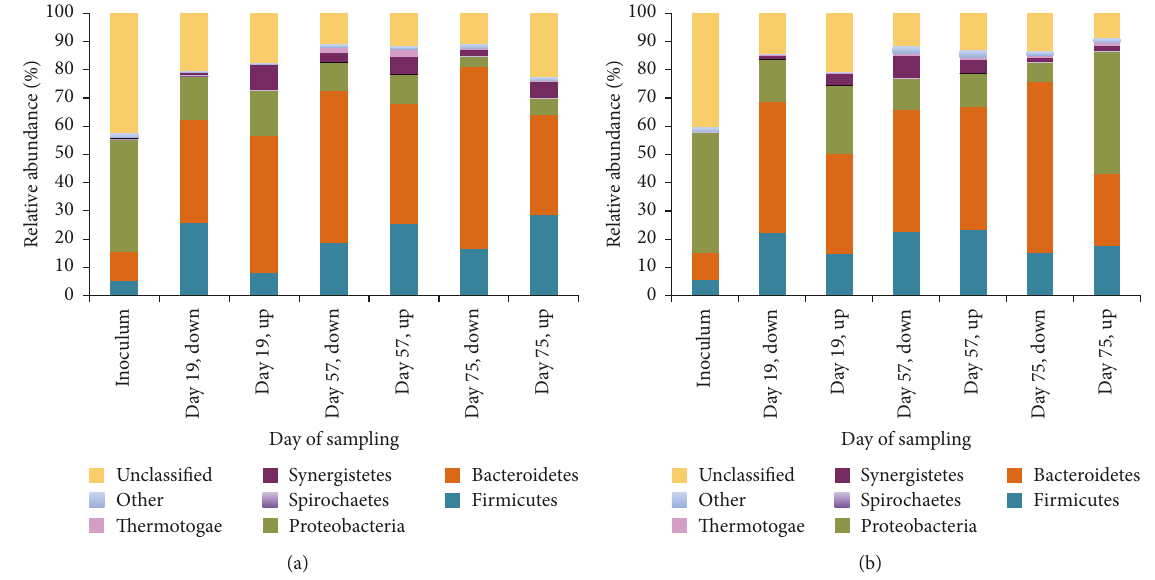
Figure 3: Microbial dynamics on phyla level in the UASB reactors (reactor 1 (a) and reactor 2 (b)) digesting microalgal biomass and sodium acetate. Phyla Armatimonadetes, Tenericutes, Actinobacteria, OD1, and Verrucomicrobia each contributed less than 1% of the total shared microbial population among all samples and were combined under the general “other” designation.